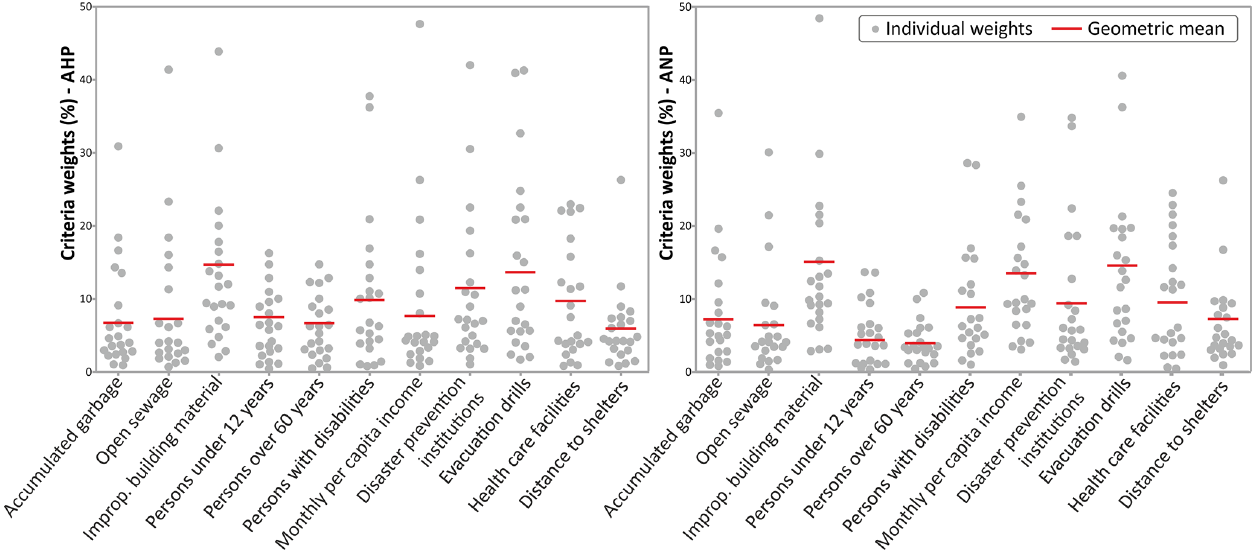
Figure 7. Diagram of dispersion of individual weight. Each point represents an expert and the red line delineates the mean.